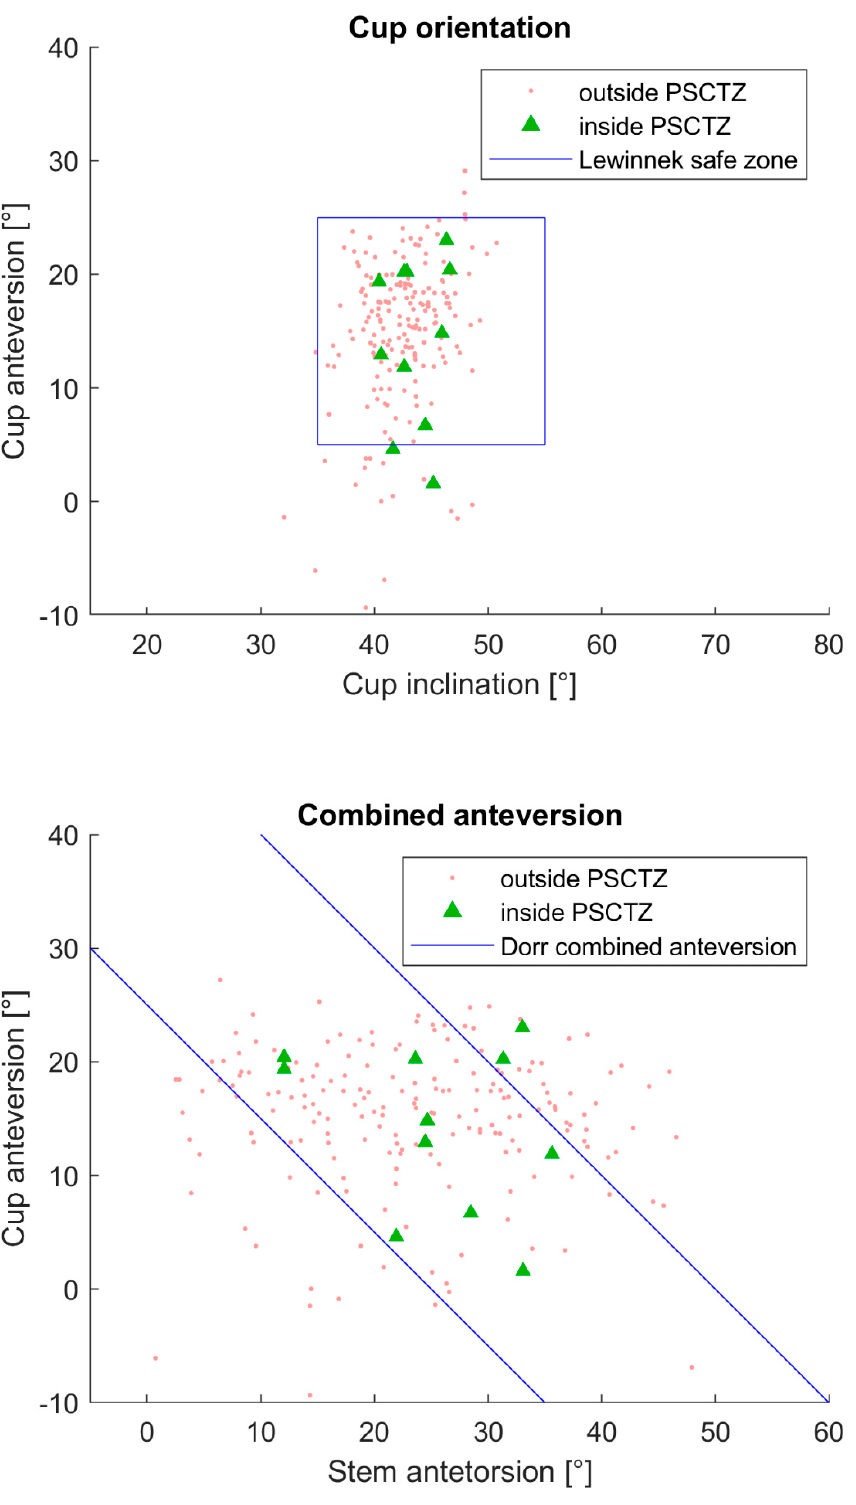
Figure 8. Distribution of the cup orientation and the combined anteversion of the PCSTZ-insiders and outsiders. The conventional safe zones by Lewinnek and Dorr are also visualized.